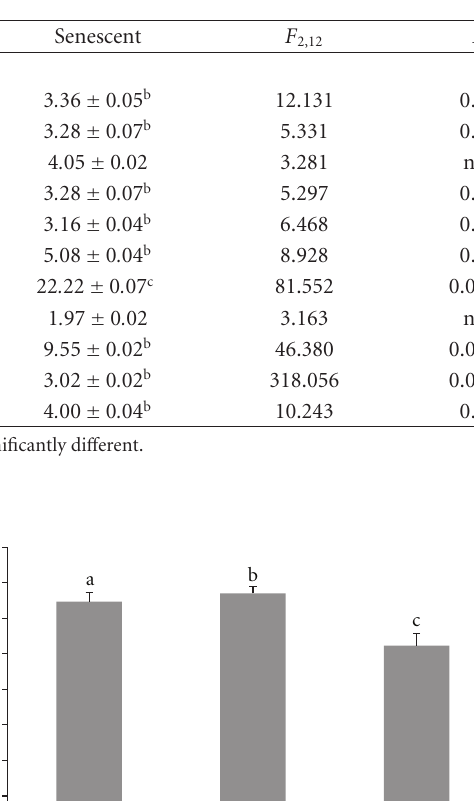
Table 1: Life cycle of D. casignetum reared on young, mature, and senescent sunflower leaves.